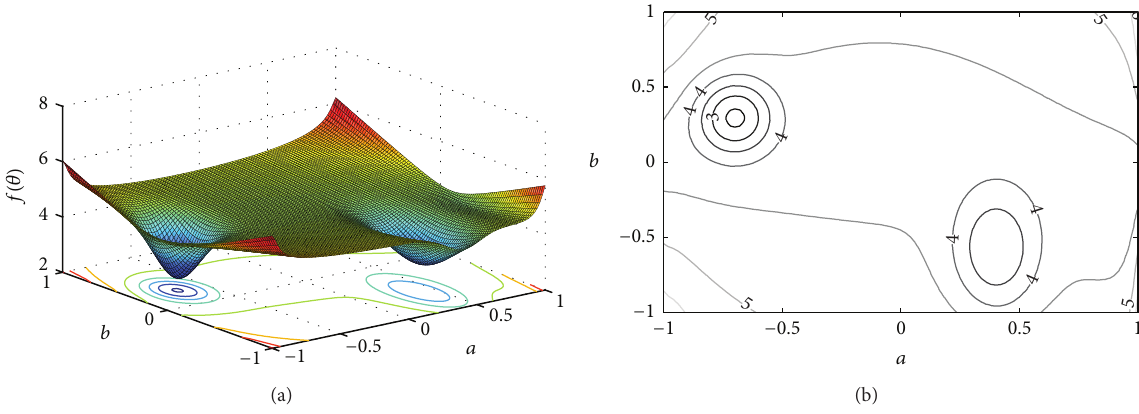
Figure 2: Multimodal error surface 𝑓(𝜃) for the first experiment: (a) tridimensional figure and (b) contour.